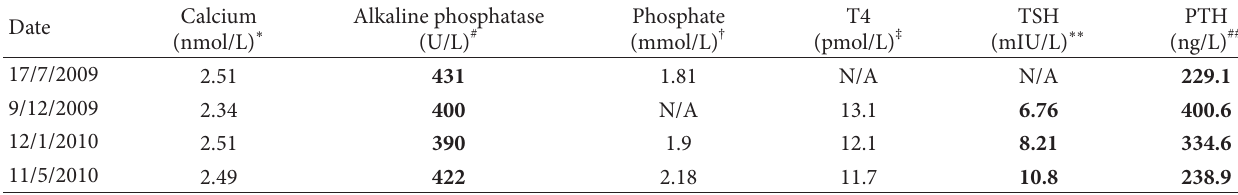
F 1: Array deletion map of area on 17q11.2 with deleted genes listed. T 1: Serial biochemistry